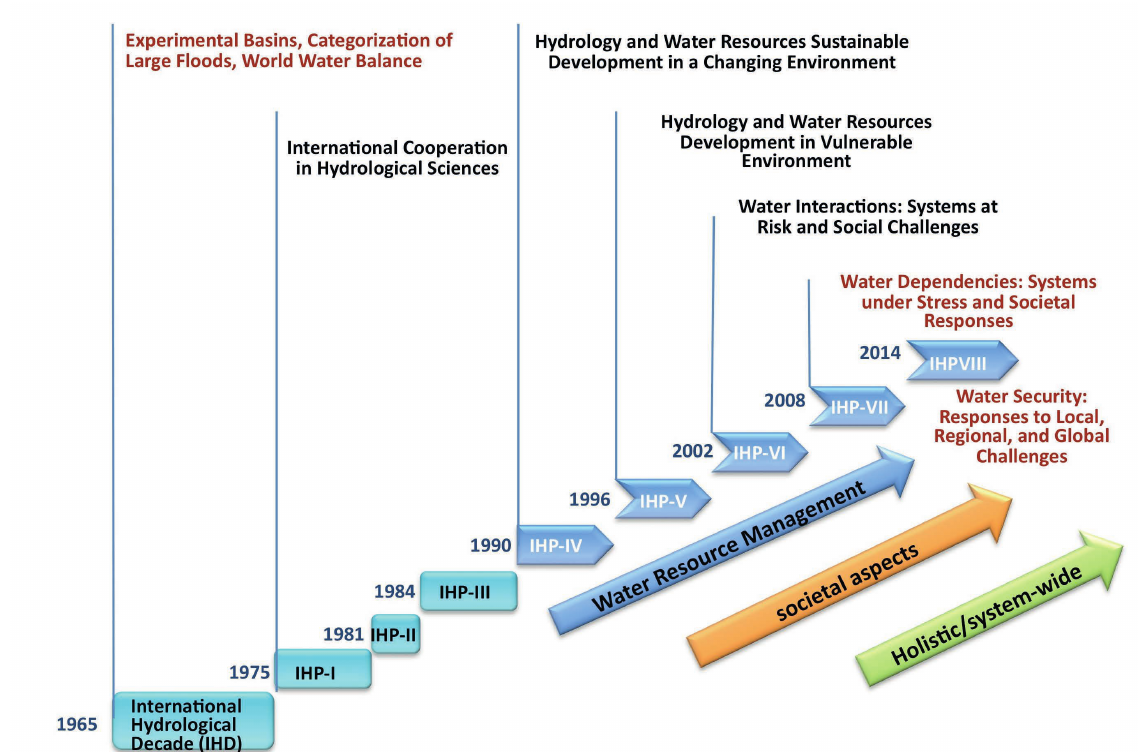
Fig. 2 Evolution of the International Hydrological Programme (IHP) of